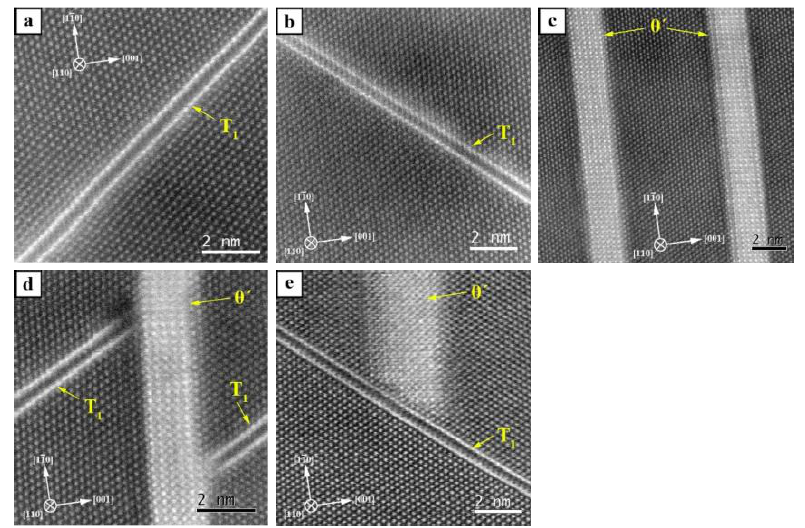
(cid:1) (cid:0) 111 ; Al